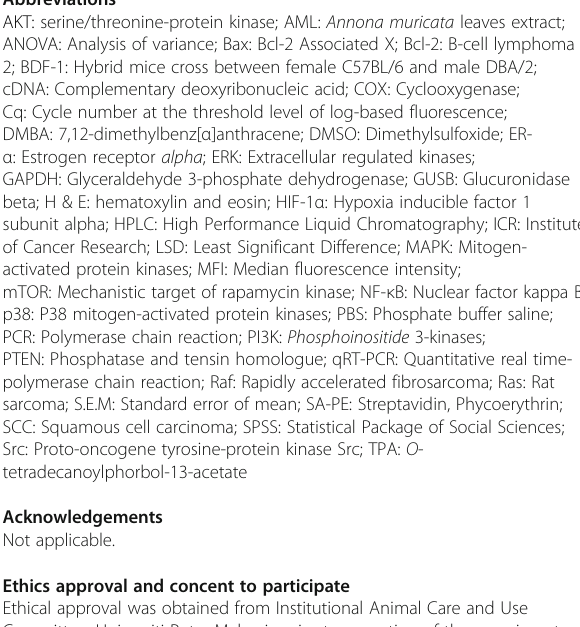
Additional file 1: Figure S1. Depiction of molecular mechanism of antitumor promotion effect by annonacin in two-stage mouse skin tumorigenesis. (DOCX 84